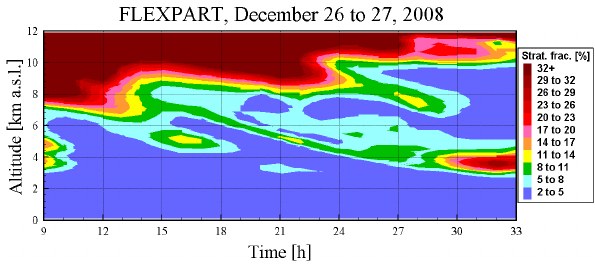
Figure 6. Time series of ozone from lidar measurements on 26 and Fig. 6. Time series of ozone from lidar measurements an December 26 and 27, 2008, showing a very thin stratospheric air intrusion descending from the tropopause to almost 3 km a.s.l.; after the 27 December 2008, showing a very thin stratospheric air intrusion descent the intrusion seems to climb again to more than 4 km descending from the tropopause to almost 3kma . s . l . ; after the de- scent the intrusion seems to climb again to more than 4km.